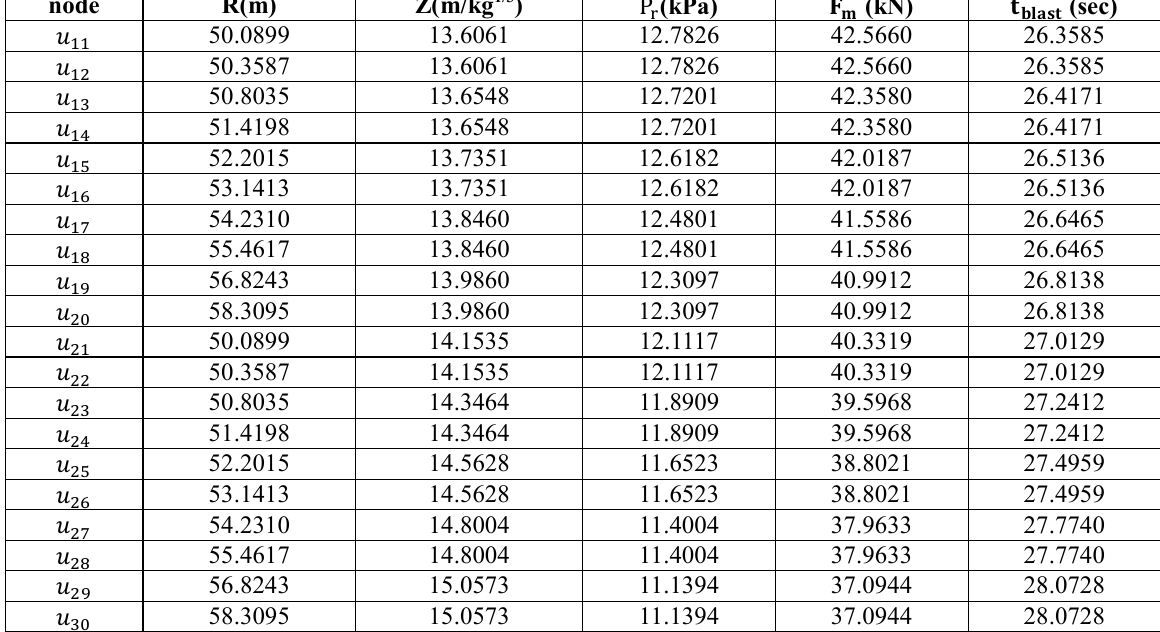
Blast load for 20 DOF